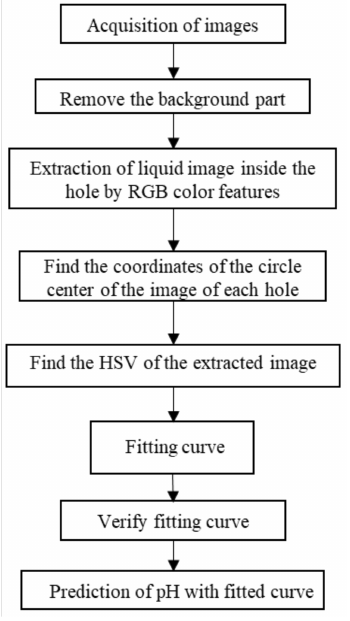
Figure 2. Program design.